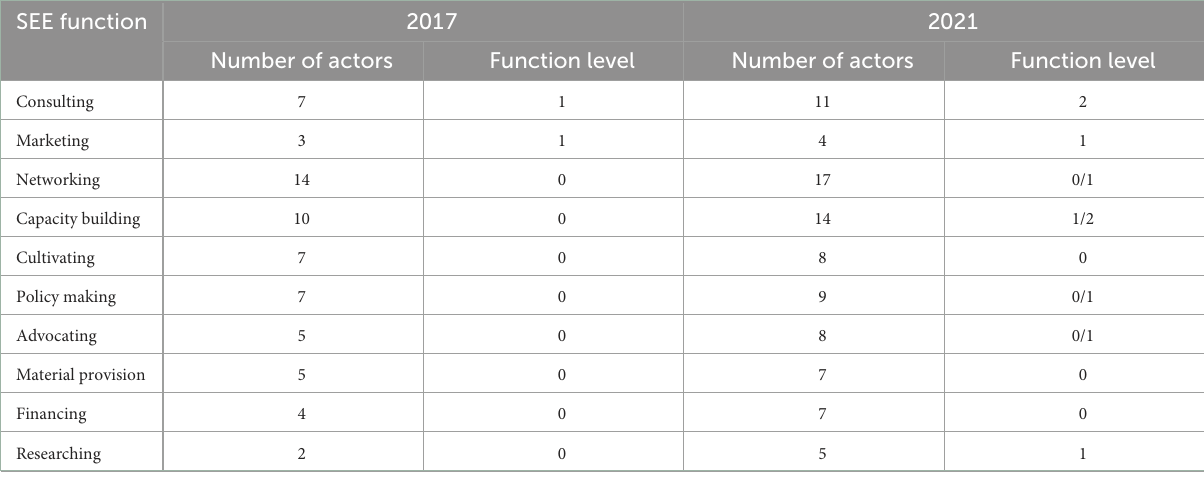
TABLE 8 The number of actors involved and overall function performance level (0 = missing, 1 = minimal, 2 = intermediate, 3 = full) of Phoenix area SEE functions in 2017 vs. 2021. SEE function